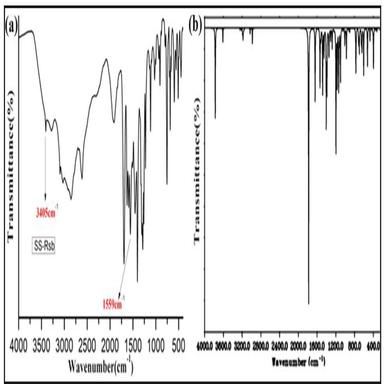
(a) Experimental Infrared spectrum of H2L and (b) computational Infrared spectrum of H2L DFT/6–311++G(d,p).